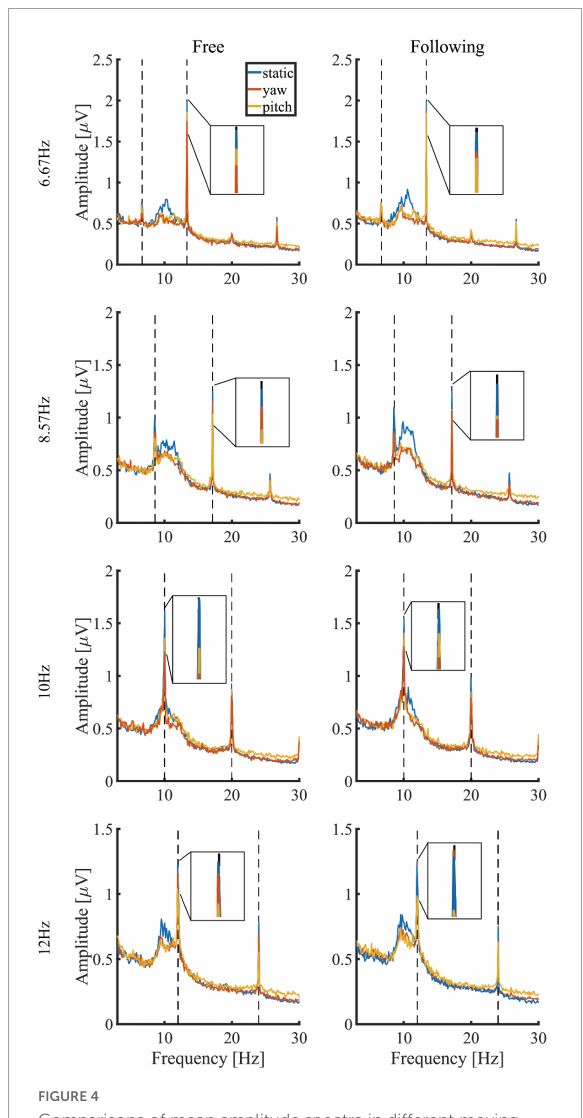
FIGURE4 Comparisons of mean amplitude spectra in different moving tasks and